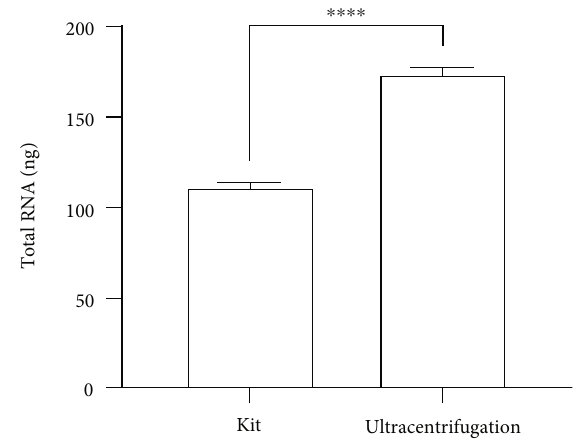
Figure 3: Total RNA obtained using Qubit. The mean total RNA obtained from exosomes isolated by ultracentrifugation was signi fi cantly higher ( 173 : 88 ± 1 : 4ng ) ( n = 3 ) compared to kit samples ( 111 : 25 ± 0 : 98 ng ) ( n = 3 ). The P value indicates the di ff erence between means of total RNA from exosomes using UC and the kit ( ∗∗∗∗ indicates P < 0 : 0001